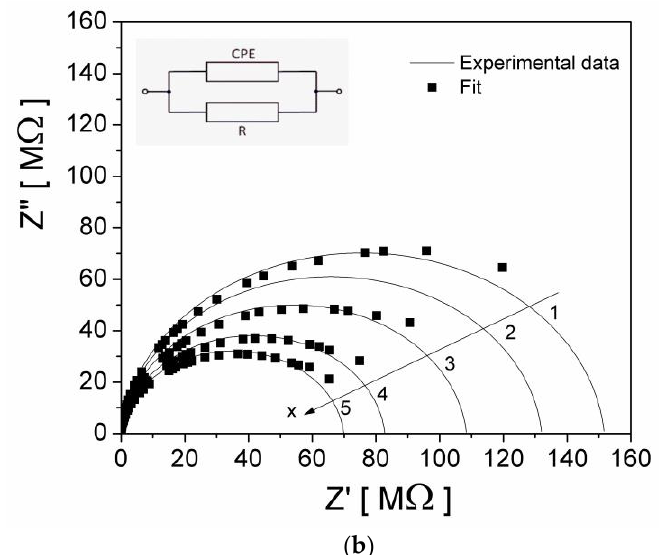
Figure 5. ( a ) The frequency dependence of the real (Z′) and imaginary (Z′′) components of the complex impedance of the investigated composite samples at different volume fractions x of Al particles; ( b ) the Nyquist plots of the impedance spectra of samples and their according fitting with the electrical equivalent circuit.